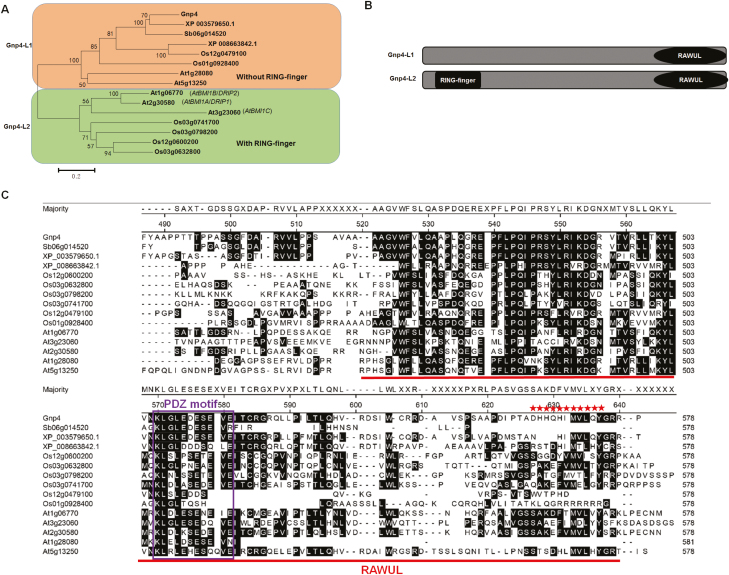
Phylogenetic tree and analysis of amino acids of Gnp4/LAX2. (A) Phylogenetic relationship among Gnp4 and homologous plant proteins. The tree was generated using the MEGA6.0 program by the neighbor-joining method. (B) Schematics of the Gnp4-L1 and Gnp4-L2 protein groups. The RING finger and RAWUL domains are indicated. (C) The amino acids of RAWUL in Gnp4 and homologous proteins. Alignment was conducted using the Megalign program in the DNASTAR software package. The RAWUL domain is indicated in red, the purple box indicates the PDZ binding motif, and the red stars indicate the amino acids required for its interaction with OsIAA3 and OsIAA17.